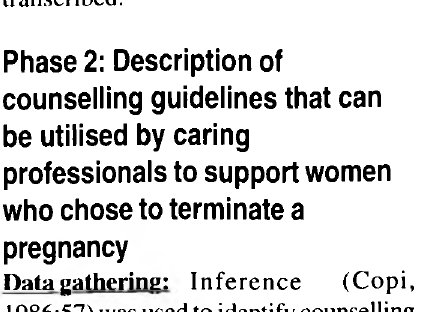
highlighted by direct quotations from the participants and accompanying literature